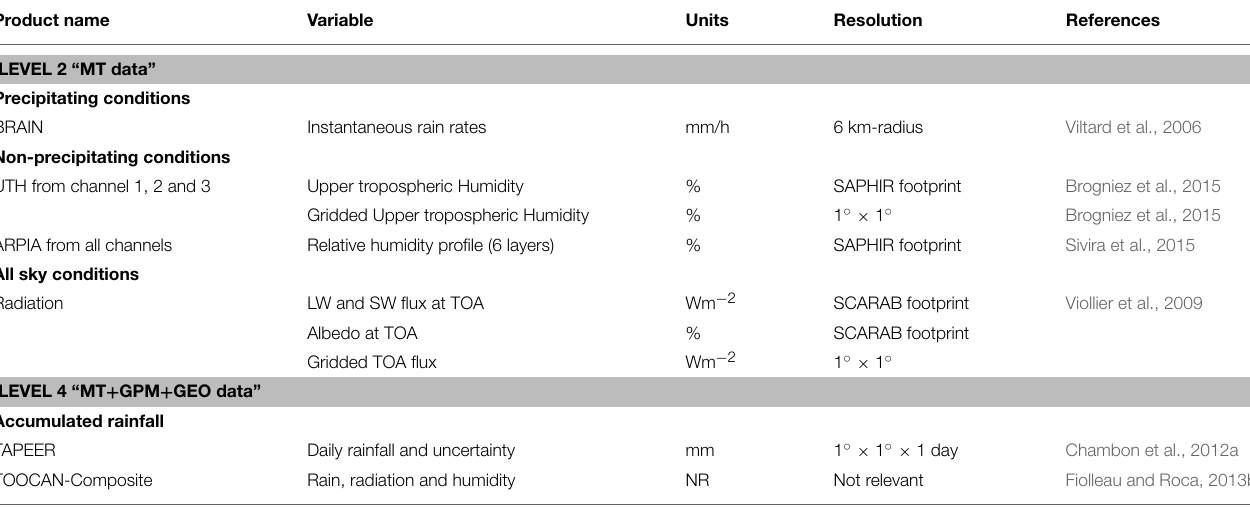
TABLE 3 | Summary of the main products derived from the Megha-Tropiques